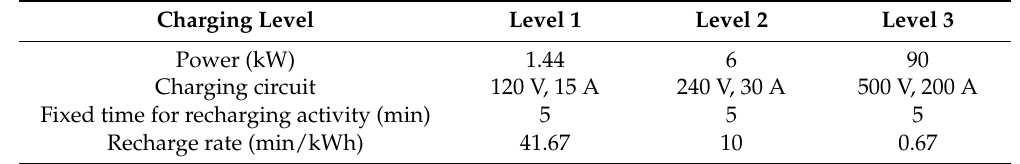
Table 2. BEV charger specifications [8].